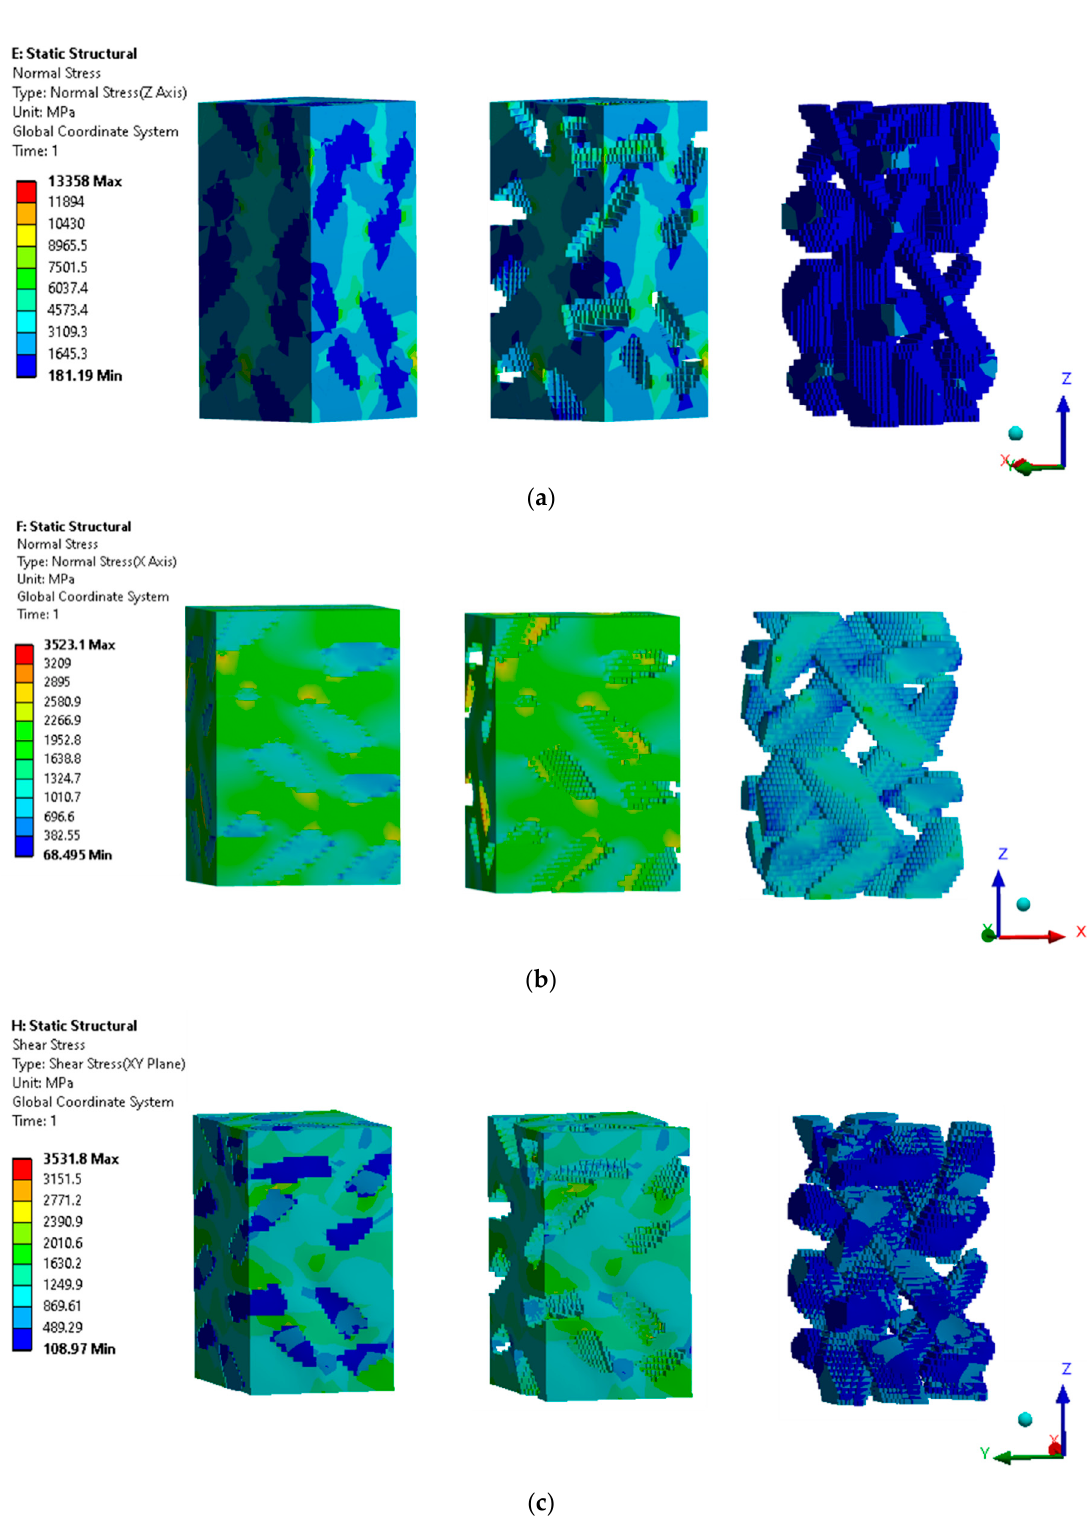
Figure 8. Conditions after analysis, ( a ) pure tension in z; ( b ) pure shear in zy plane; ( c ) pure tension in x; and ( d ) pure shear in the xy plane.